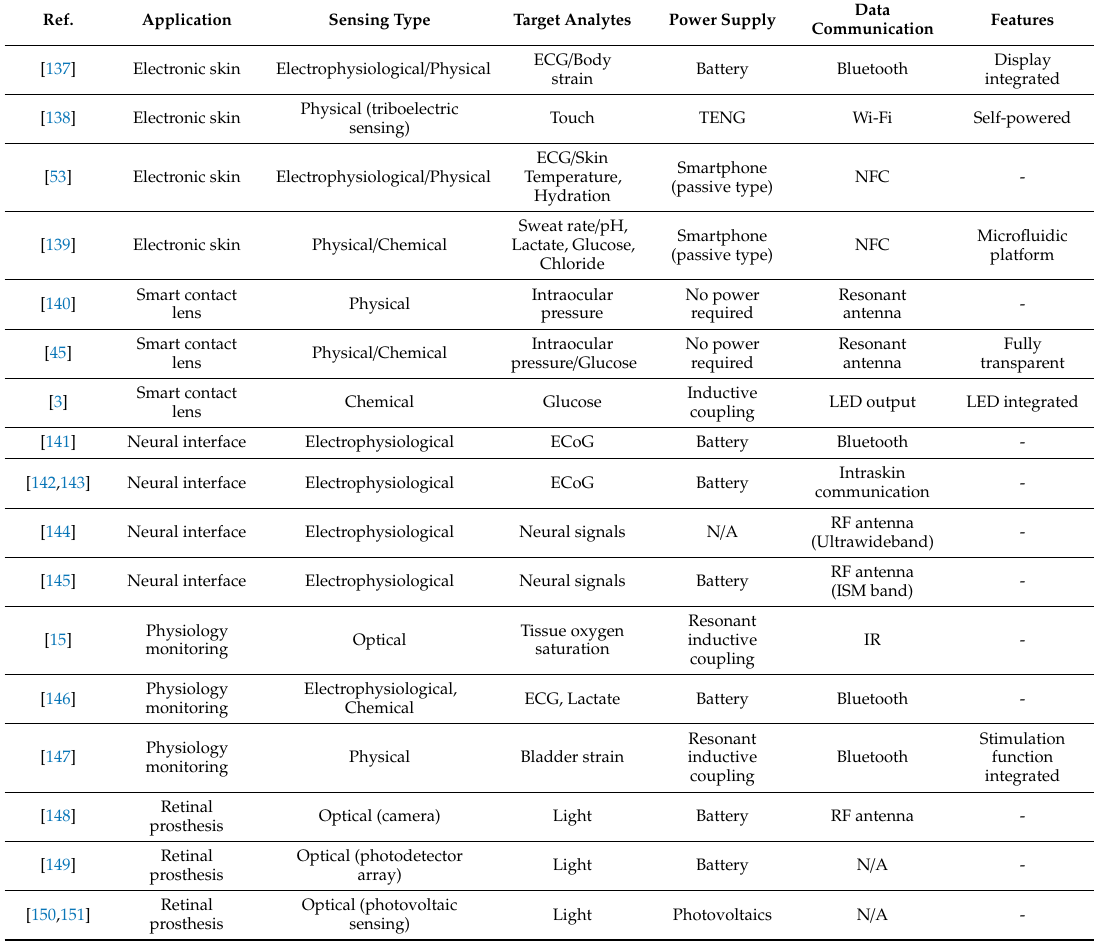
Table 2. Summary of the reviewed works in various applications.